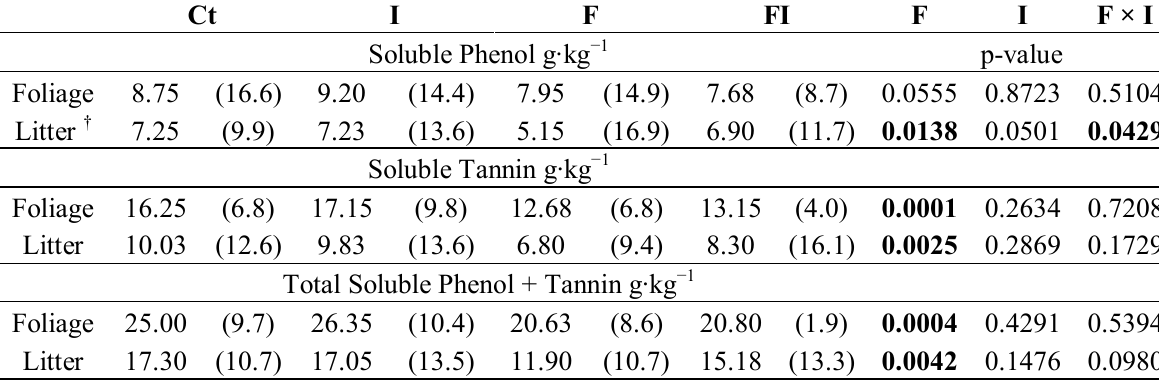
Table 4. Mean loblolly pine soluble phenol and tannin fraction concentrations in control (Ct), irrigation (I), fertilization (F), and fertilization × irrigation (F × I) treatments. Coefficients of variation are shown in parentheses. Soluble phenol is cold 0.30 M TCA extractable and soluble tannin is hot 0.15 M TCA extractable. Statistically significant p -values are shown in bold for the effects of fertilization (F), irrigation (I), and their interaction (F × I). † Indicates statistical analysis performed on log transformed